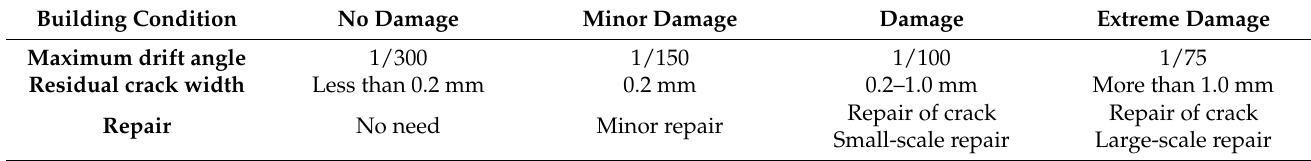
Table 1. Relationship between the RC moment frame system and maximum interstory drift angle [30]. Building Condition